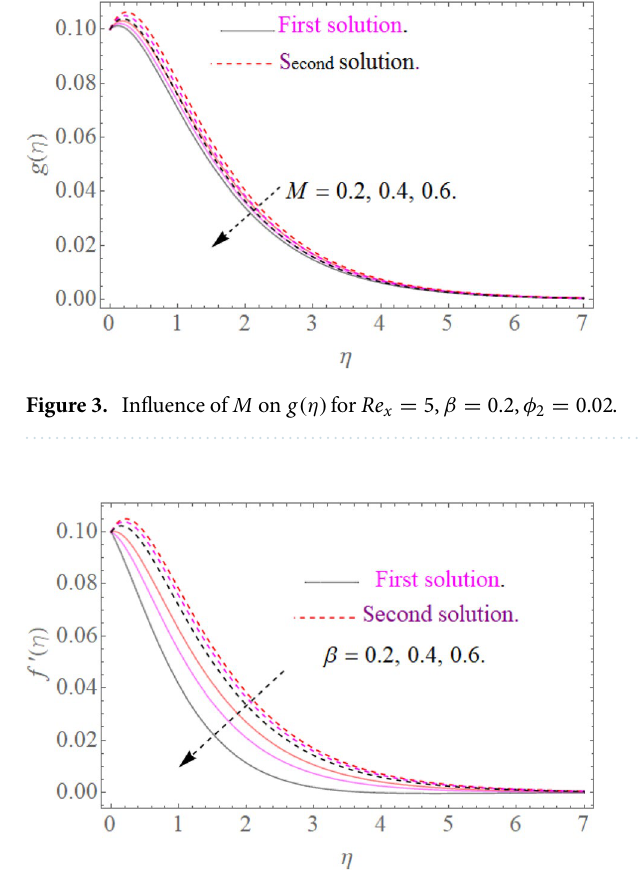
Figure 4. Influence of β on f ′ (η) for M = 0.9, φ 2 = 0.02